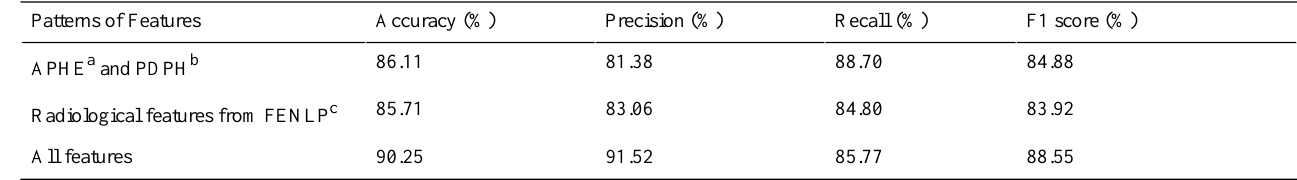
Table 3. Performance of different patterns of features for liver cancer